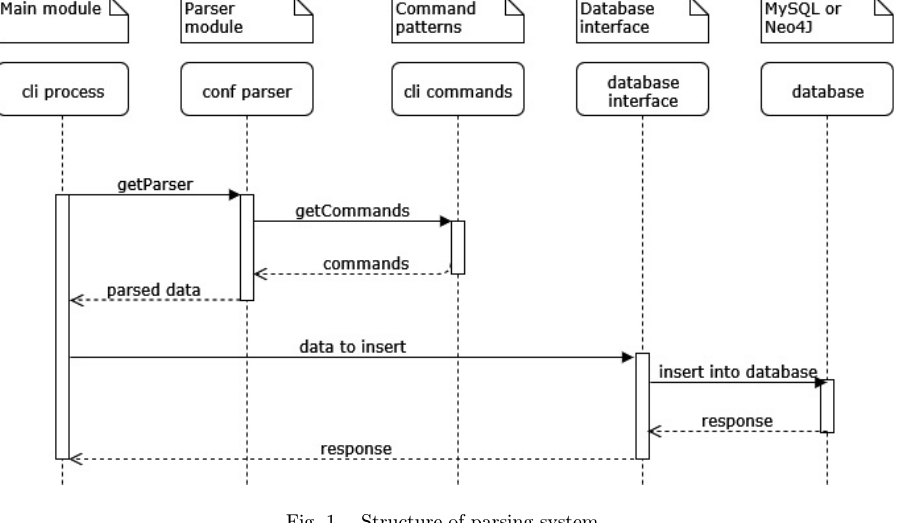
Fig. 1. Structure of parsing